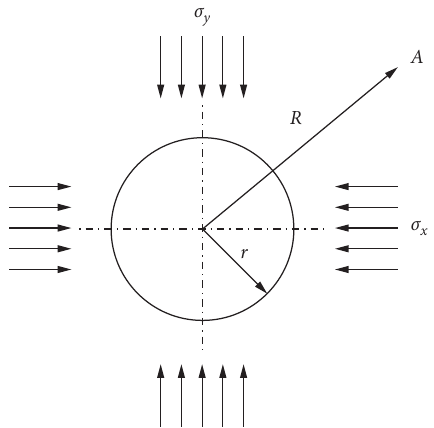
Figure 2: The computational mechanics